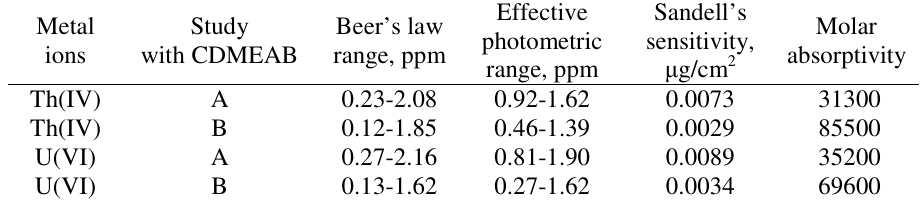
Table 2. Photometric determination of Th(IV) and U(VI) metal ions with CRAS in absence and presence of CDMEAB